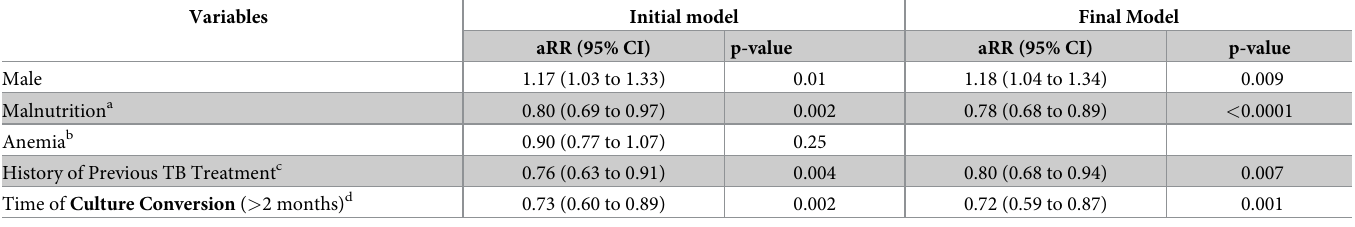
Table 2. Multivariate